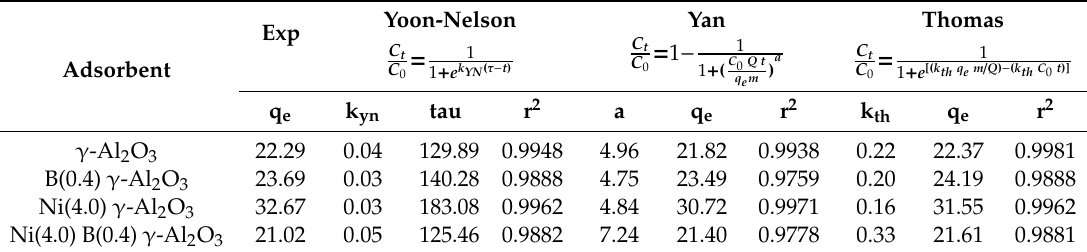
Table 4. Kinetics parameters obtained by the three models studied for QN.